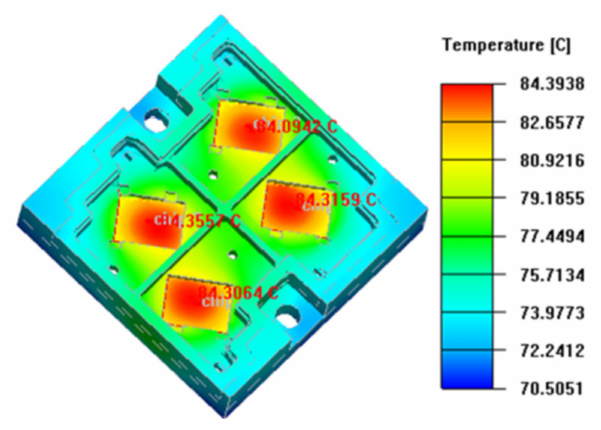
Figure 4. Thermal simulation showing the amplifier working temperature distribution diagram.